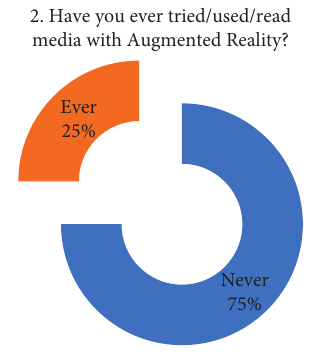
Figure 6: Teachers’ experiences with using AR.